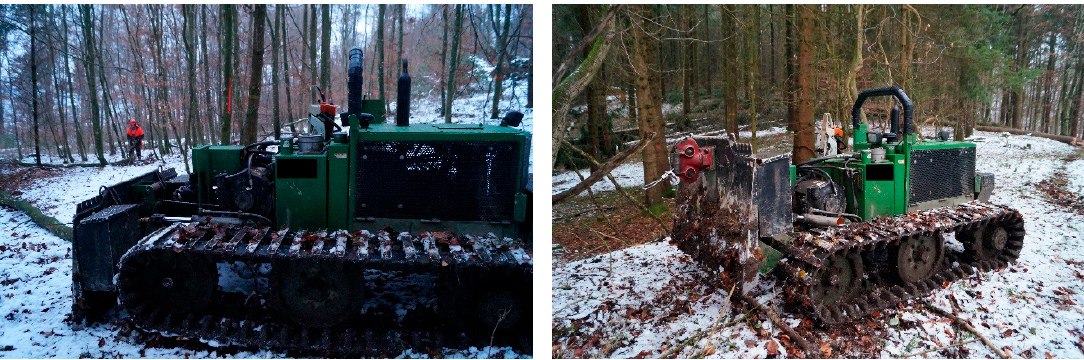
Figure 1. Remote-controlled mini forestry crawler (MFC) tested in this study.